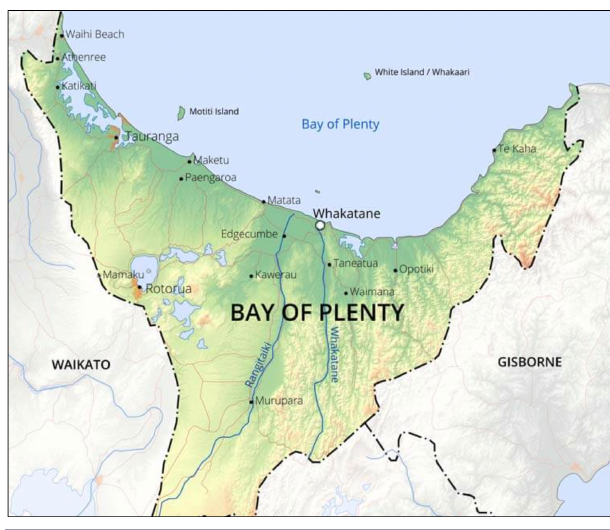
Fig. 1 . Bay of Plenty region, Aotearoa-New Zealand.